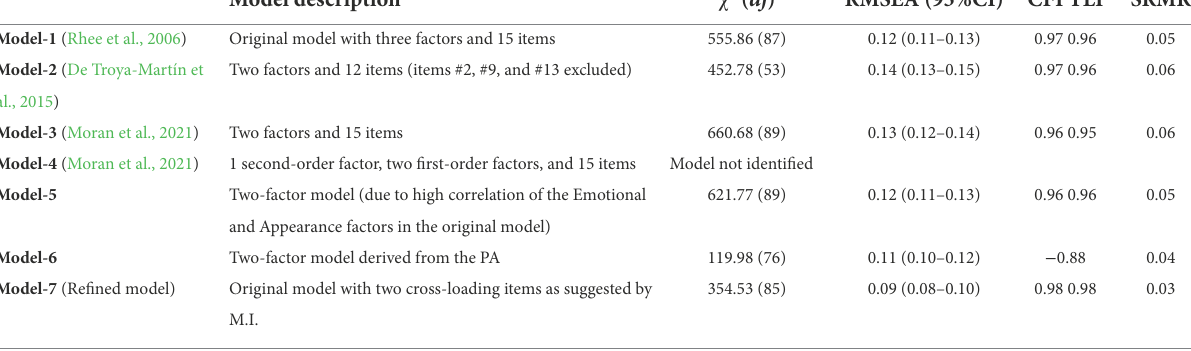
TABLE 3 Fit results of the competing models tested ( N